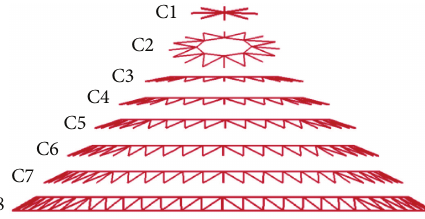
Figure 2: Labeled number of every segment on the reticulated